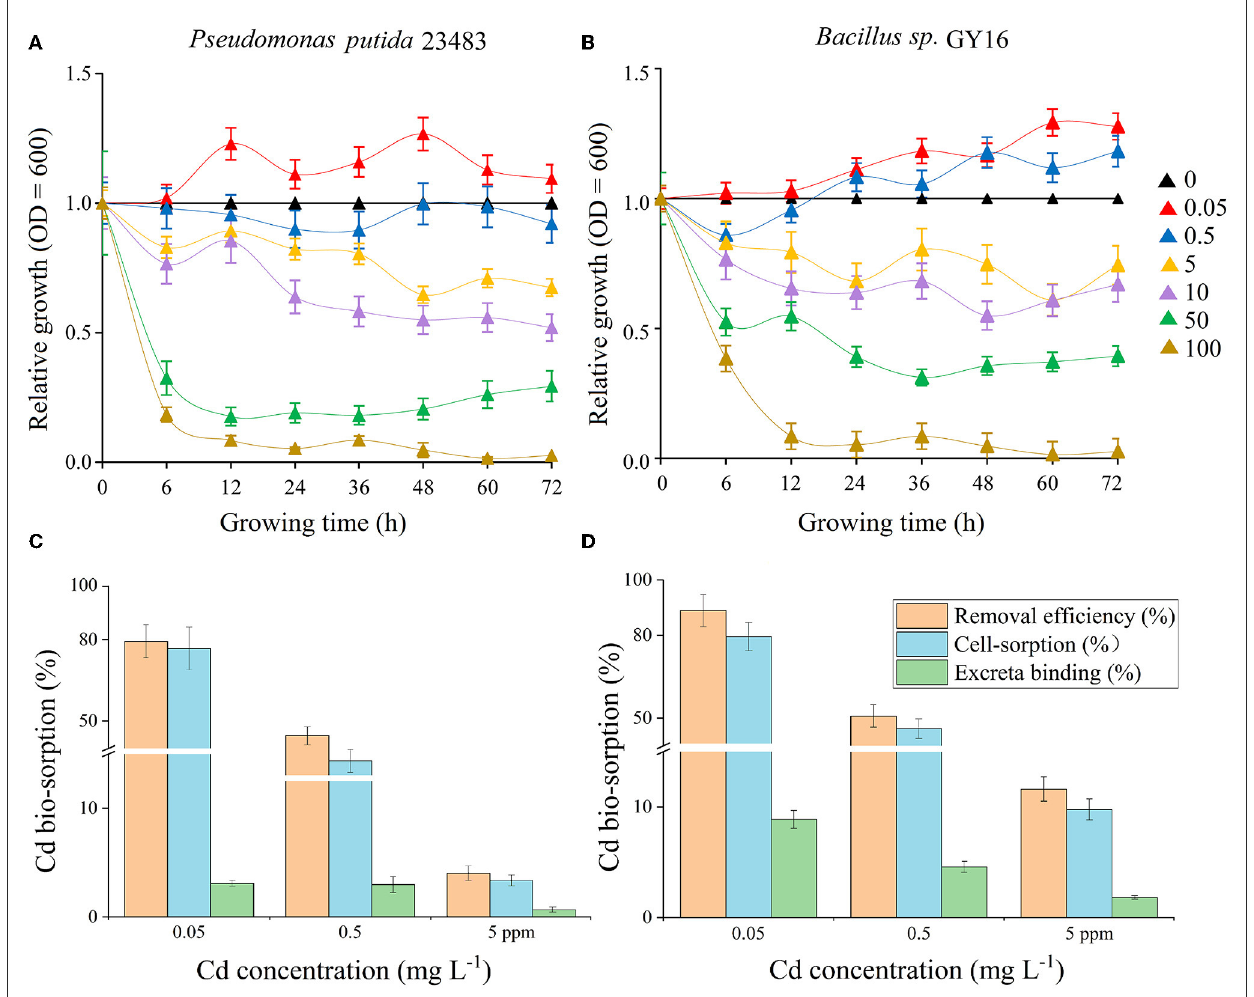
FIGURE1 (A, B) Tolerance test of Cd concentrations of 0, 0.05, 0.5, 5, 10, 50, and 100mg L − 1 on the growth of microbial strains Pseudomonas putida 23483 (A) and Bacillus sp. GY16 (B) . The relative growth indicates the growth efficiency in the presence of Cd of different concentrations (0.05–100mg L − 1 ) compared with the growth in the medium without Cd (0mg L − 1 ). (C, D) The removal efficiency, cell-sorption, and excreta binding of Cd during the adsorption equilibrium phase (24h) by Pseudomonas putida 23483 (C) and Bacillus sp. GY16 (D) under different Cd concentrations (0.05, 0.5, and 5mg L − 1